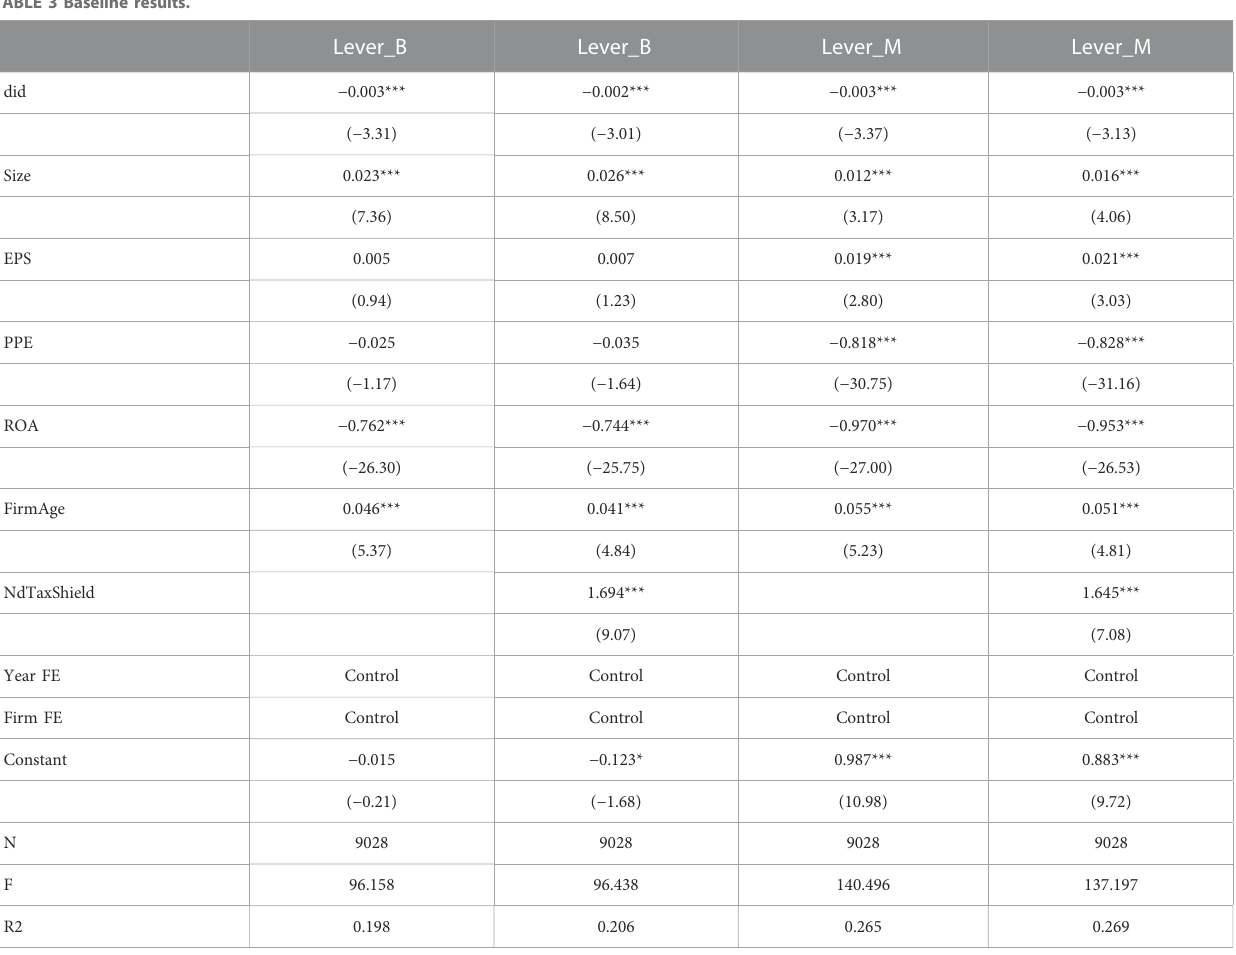
TABLE 3 Baseline